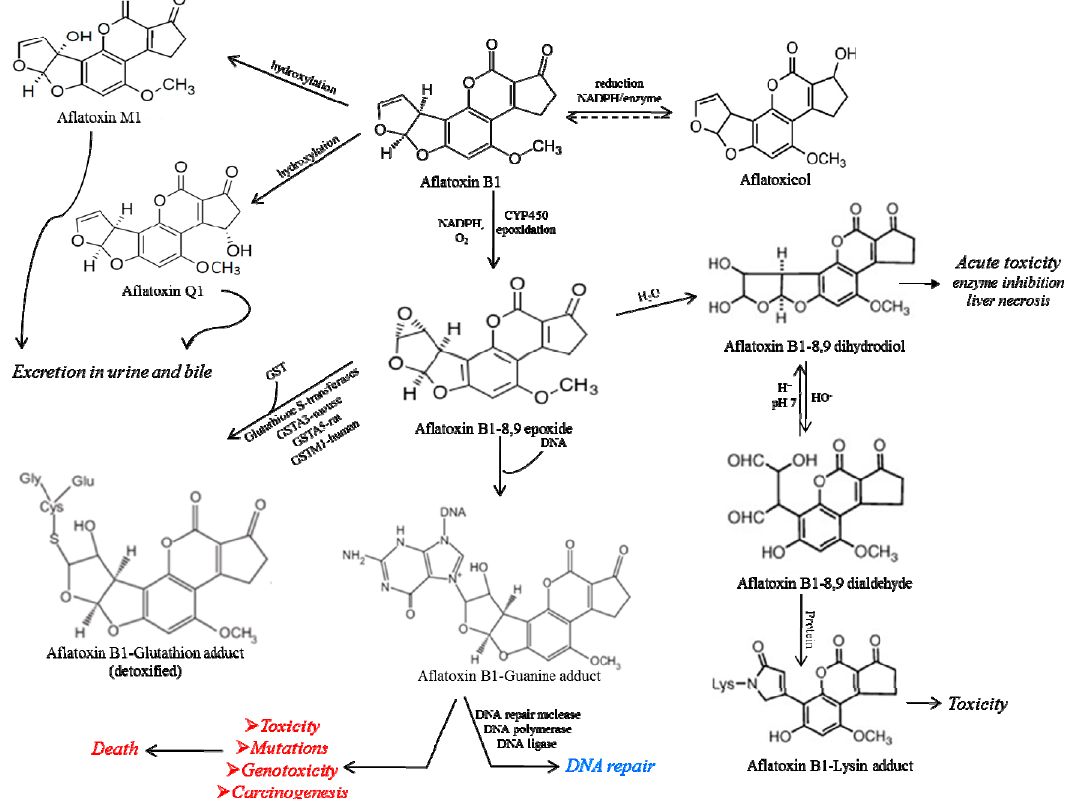
Figure 2. The biodegradation of aflatoxin B 1 through metabolic pathways. DNA = deoxyribonucleic acid. NADPH = nicotinamide adenine dinucleotide phosphate. CYP450 = cytochrome P450. GST = glutathione-S-transferase.